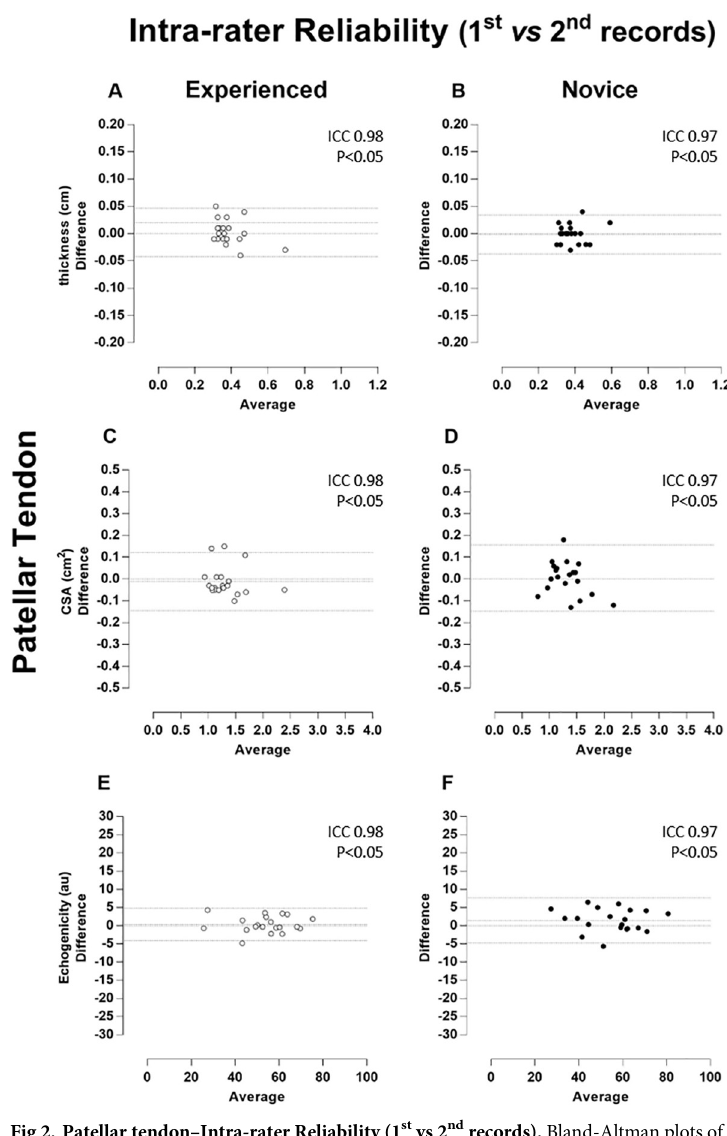
Fig 2. Patellar tendon–Intra-rater Reliability (1 st vs 2 nd records). Bland-Altman plots of the intra-rater comparison between first (1 st ) and second (2 nd ) repeated records of the thickness (A and B), cross-sectional area (CSA, C and D), and echogenicity (E and F) taken on the patellar tendon. The images taken by the experienced rater are in the left column (A, C, and E) and plotted by white circles, whereas those taken by the novice rater are in the right column (B, D, and F) and plotted by black circles. Besides the zero lines, the bias line and random error lines showing the 95% limits of agreement are represented by dashed lines.